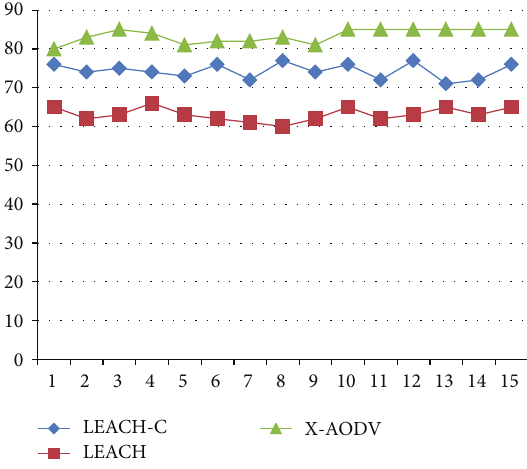
Figure 6: X-AODV comparison with different